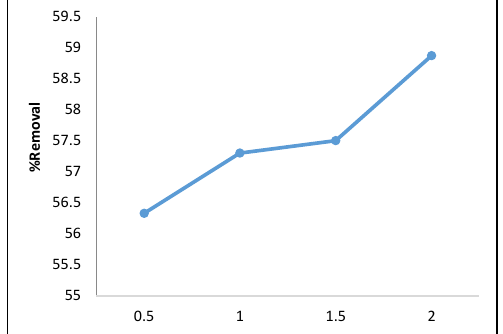
Fig. 5. The removal efficiency of Cr (VI) by ferrous sulfate at different contact times (30, 40,50,60,90,and 120